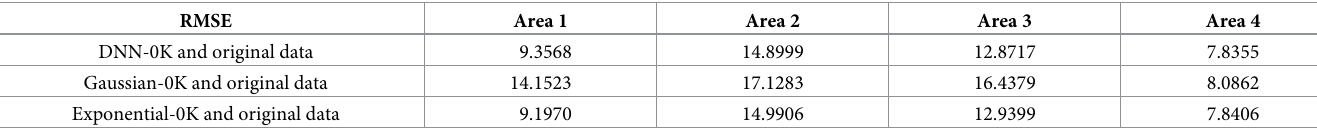
Table 5. RMSE between the interpolation results and the original data in the four areas. RMSE